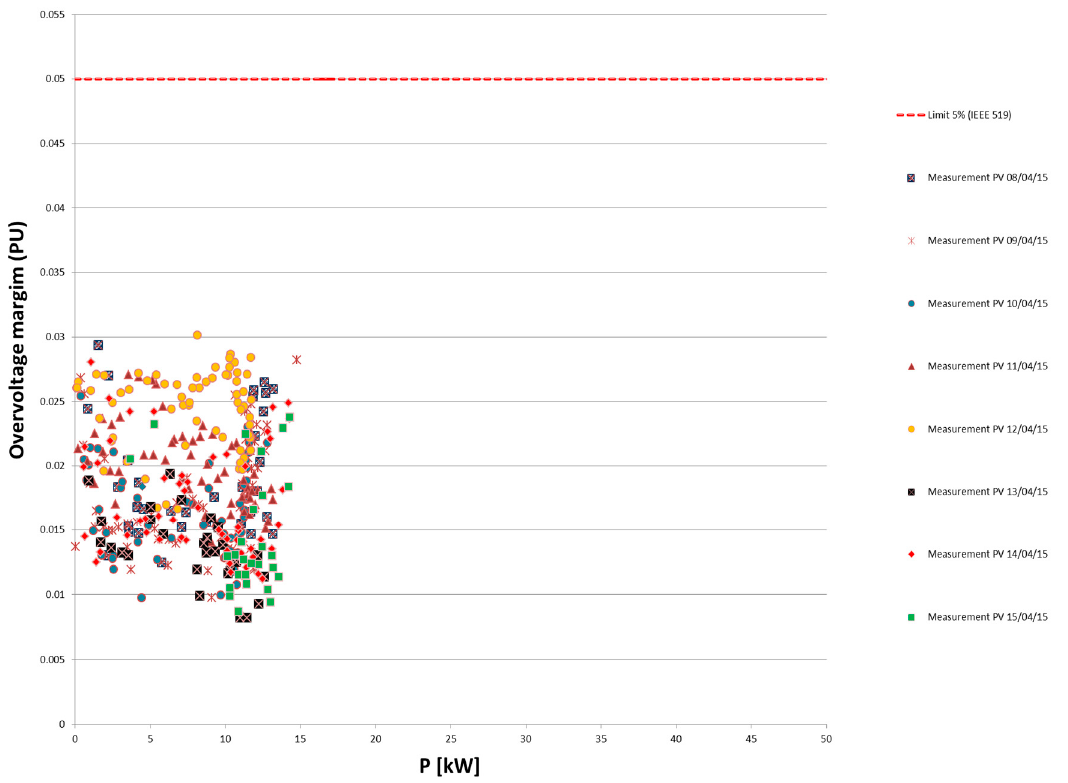
Figure 4. Hosting capacity experimental data.